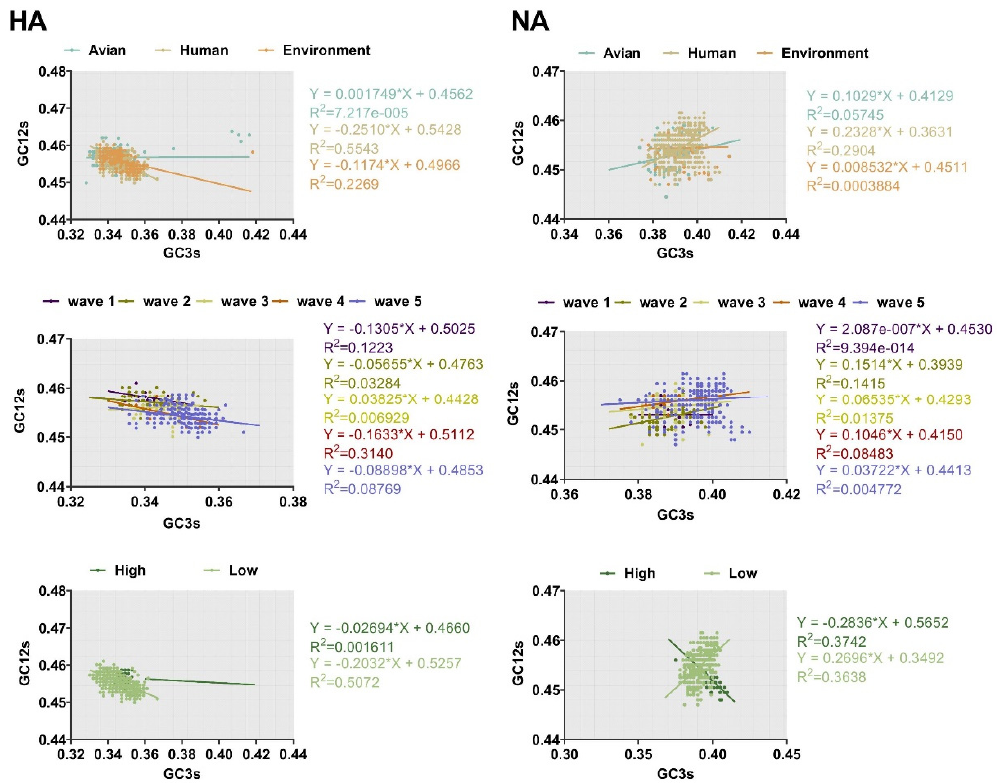
Figure 6. Neutrality analysis of HA and NA depicted by plotting GC3s against GC12s. The higher the slope, the greater the effect of natural selection pressure. The environment, human, and avian are represented in orange, beige, and cyan, respectively. Dark purple, olive green, light yellow, orange, and light purple correspond to waves 1 to 5, respectively. Grass green corresponds to high pathogenicity.